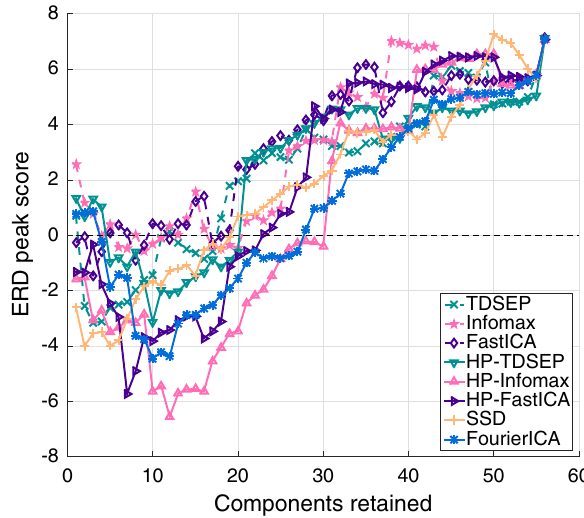
Fig. 3 ERD peak score measure in dependence of the number of components retained. Lower is better. A method which removes all neural and muscle activity would be at 0 (dashed black